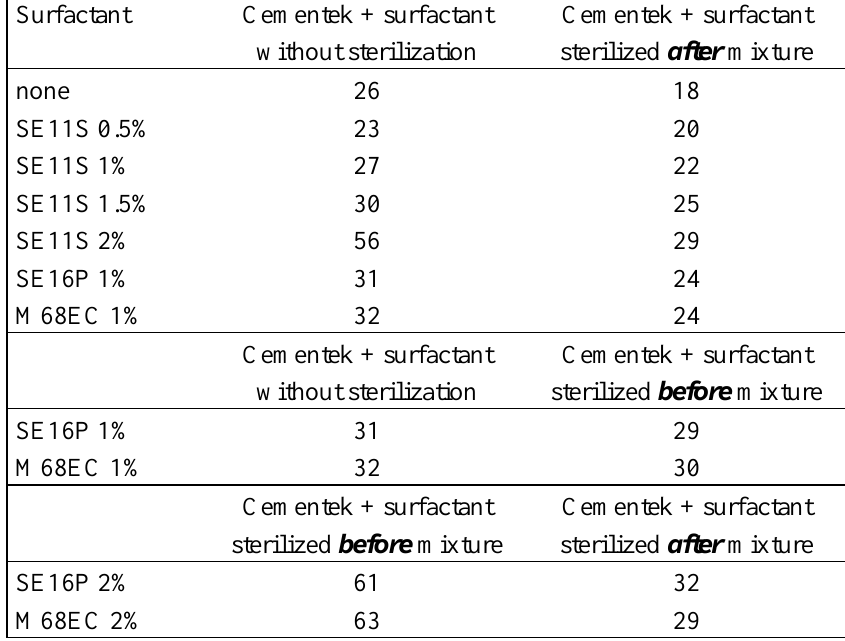
Table 1. Effect of sterilization on setting times (min).